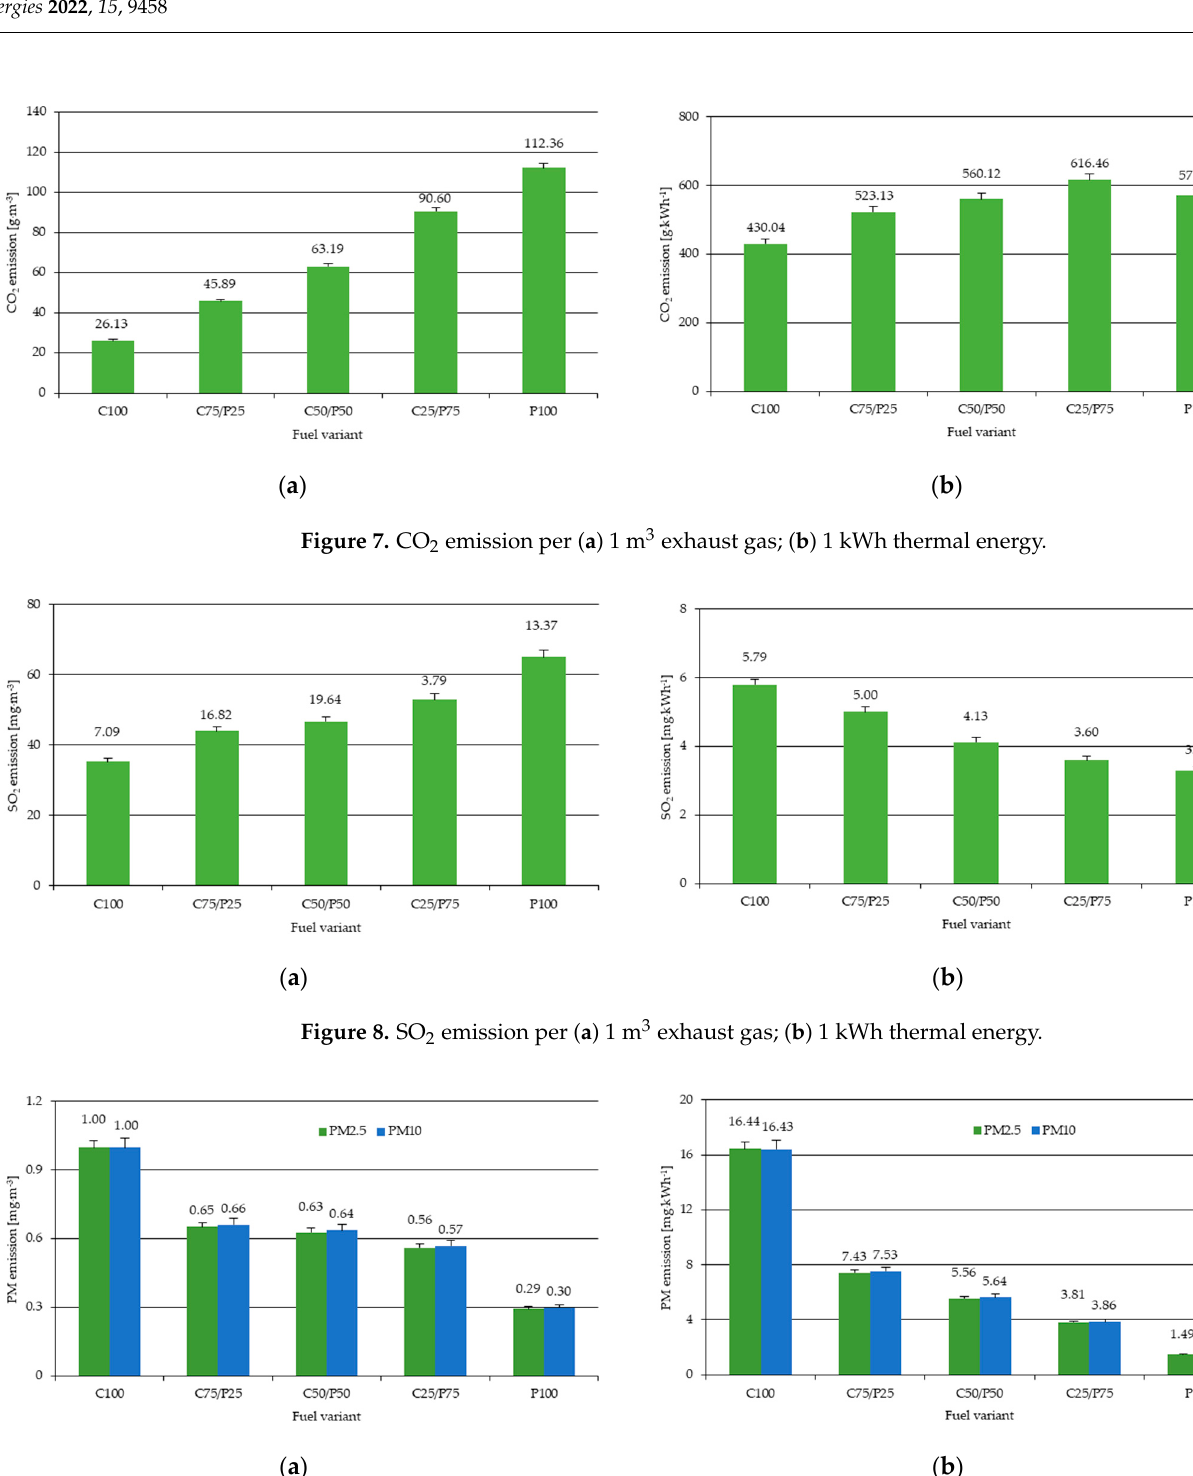
9 of 17 Figure 6. Average heat yield per kilogram of fuel. For comparison, according to Skibko et al. (2021) [73], the heat of combustion of oxy- trees at the constant volume was 17.74 MJ·kg –1 and a total humidity of 11.3%. Figure 7 shows the emission of carbon dioxide, which, in terms of one cubic meter of flue gas, was the highest for pine pellets. It should be noted that even in this case, the excess